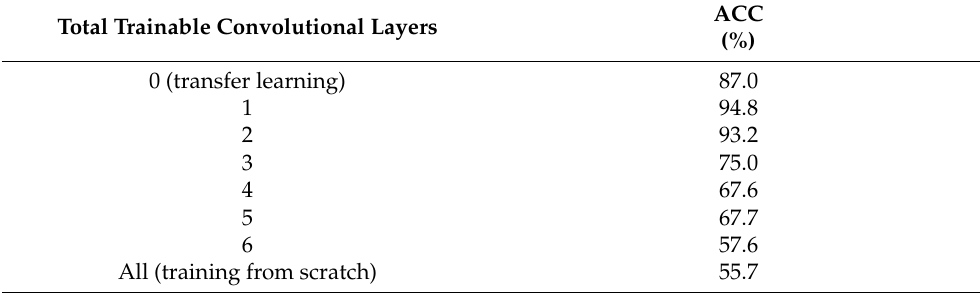
Table 5. Accuracy of ParaNet variations in distinguishing between normal and abnormal scans when altering the total number of trainable convolutional